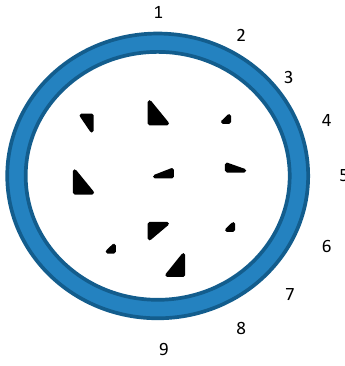
Figure 4. Arrangement of strain gauges.